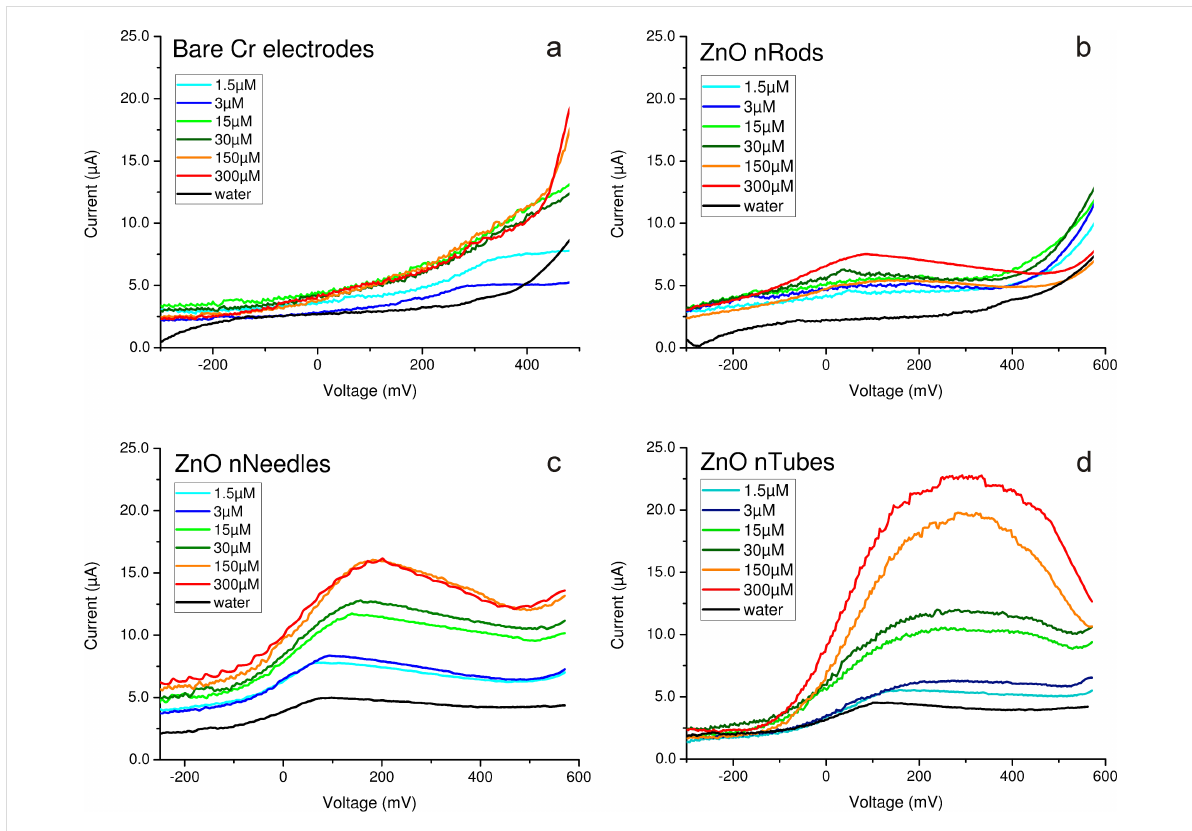
Figure 8: DPV curves for different ZnO morphologies: (a) untreated Cr electrodes, (b) nanorods, (c) nanoneedles and (d) nanotubes. As an analyte, a solution of Pb(NO 3 ) 2 at concentration of 1.5 µM to 300 µM was used.